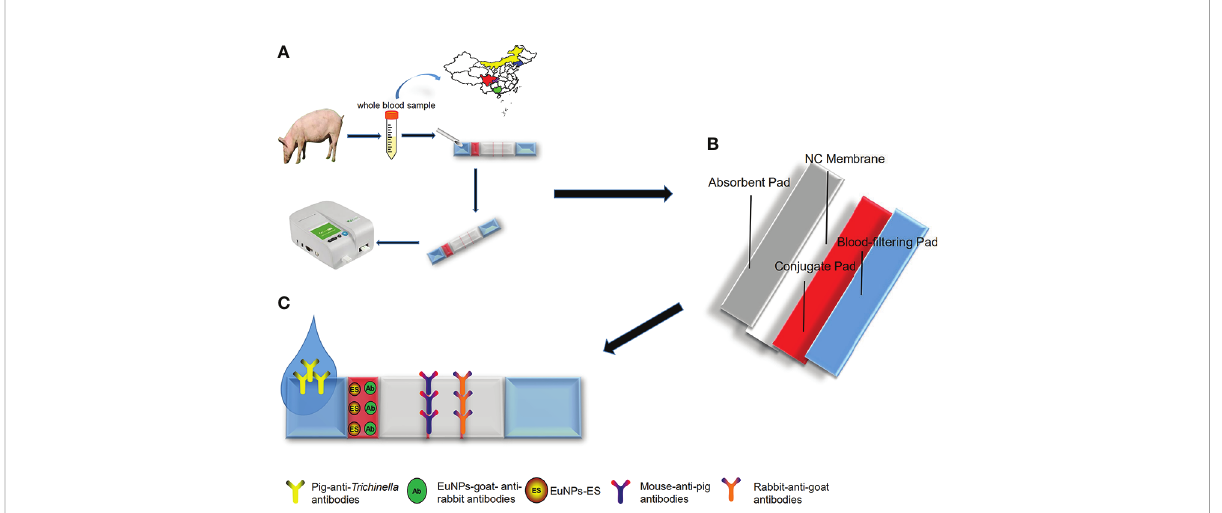
FIGURE 1 The schematic of europium(III) chelate microparticle-immunoassay strip (ECM-ICS). (A) Detecting the whole blood sample by ECM-ICS. (B) Schematic depiction of the construction of the ECM-ICS. (C) Immunochromatographic process of the